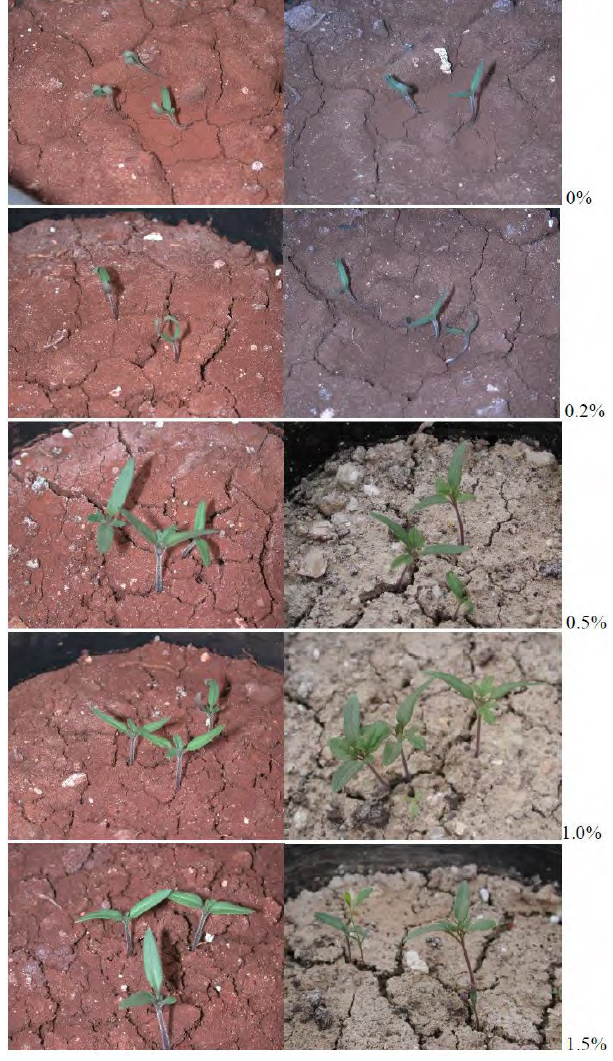
Figure 6. Visual comparison of the growth of tomatoes plants for the samples with different concentration of SAP, for red soil ( left side) and white soil ( right side). In these plants, the SAP was mixed with the surface layer of the